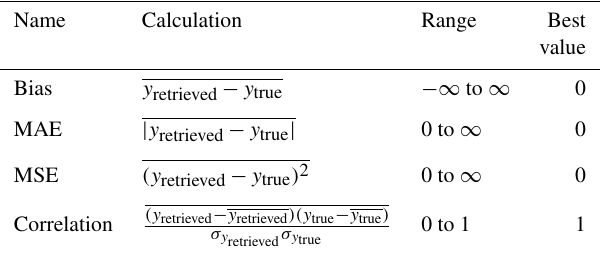
Table A1. Accuracy metrics used to assess the accuracy of quan- titative precipitation estimates y retrieved against reference measure- ments y true . Overbars are used here to denote the mean over all pixels in the test dataset and σ y to denote the standard deviation of the quantity y